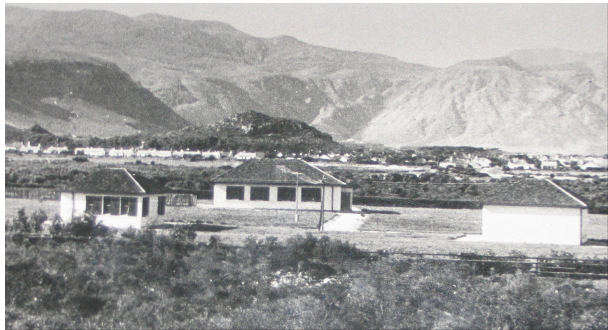
Figure 2. The magnetic observatory as it looked when established in Hermanus in 1941.